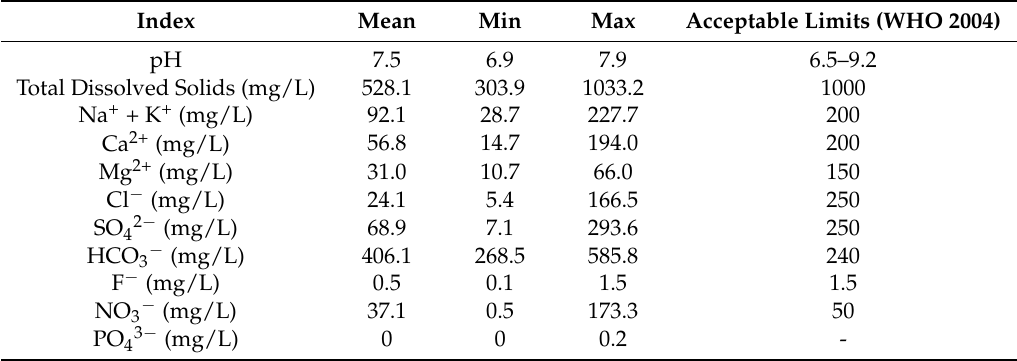
Table 1. Statistical summary of hydrochemical components in the study